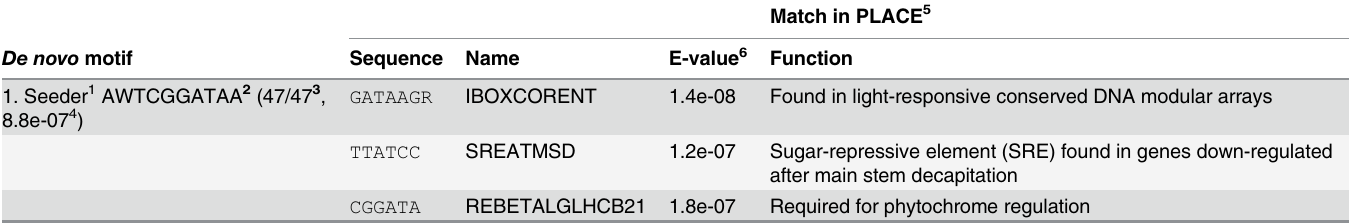
Table 2. Selected de novo motifs found in KS dehydrin promoters and their putative function identified through PLACE